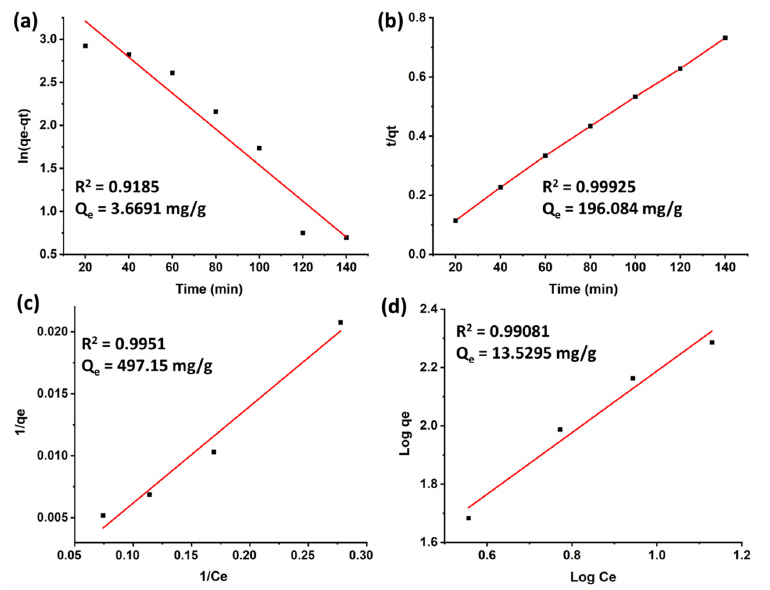
Figure 4. Kinetic models of the pseudo-first order ( a ) and pseudo-second order ( b ), Langmuir and Freundlich isotherm plot for adsorption of MG on ZIF-67 ( c , d ) respectively.